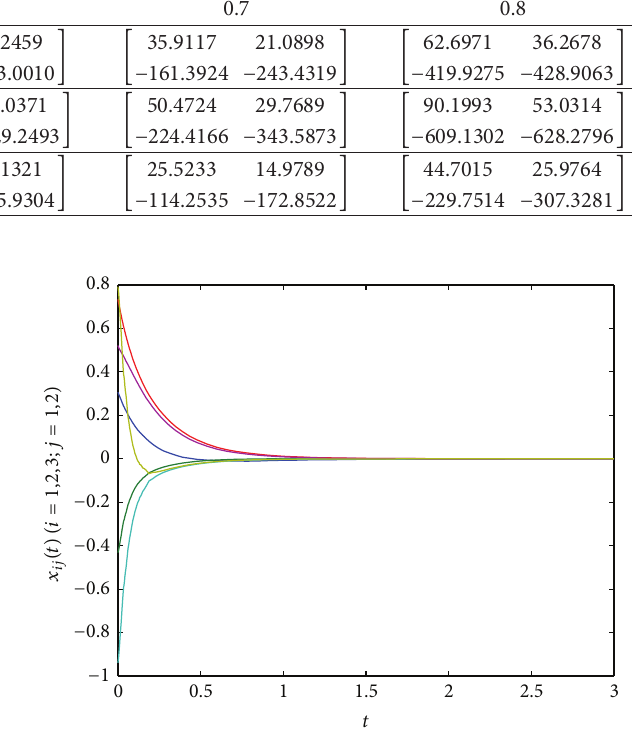
Figure 1: The position state curves of multiagent systems with 𝛼 0 = 0.7 , 𝜇 = 1 , and 𝜎 = 0 (without failure).